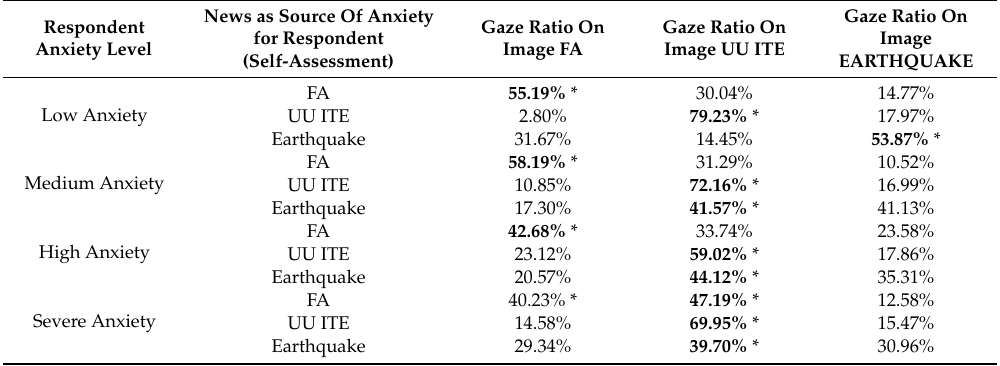
Table 26. Comparison of image gaze ratio from respondents with highest image gaze ratio on each news grouped by anxiety